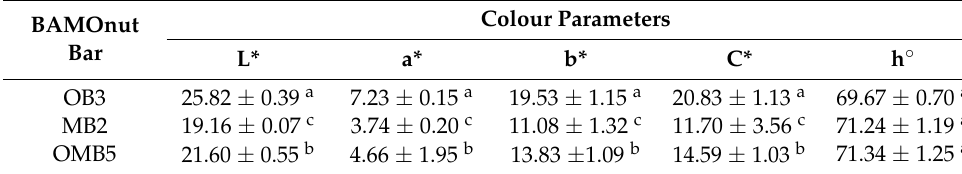
Table 4. Colour attributes of Bambara groundnut- Moringa oleifera snack bar. BAMOnut